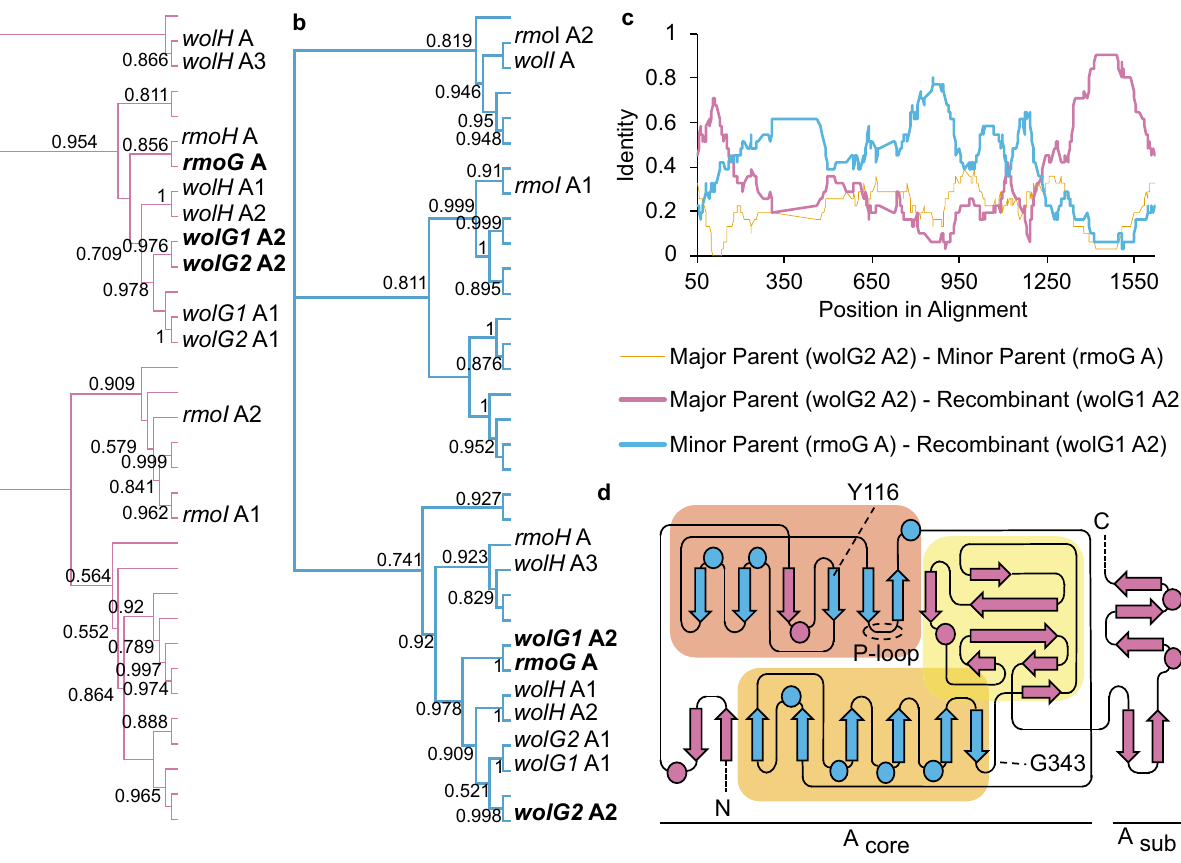
Fig. 4 Evidence for the intragenomic recombination of adenylation domains. a DNA phylogeny of the external region of the adenylation domains, showing the close relationship of the major parent, wolG2 A2, and the recombinant, wolG1 A2. b DNA phylogeny of the internal region of the adenylation domains, showing the close relationship of the minor parent, rmoG A, and the recombinant, wolG1 A2. c Nucleotide identity between the three adenylation domains based on a 50 nucleotide sliding window. d Topology of an adenylation domain based on ref. 104 , showing the predicted recombination sites Y116 and G343. Features are colour-coded according to panel a